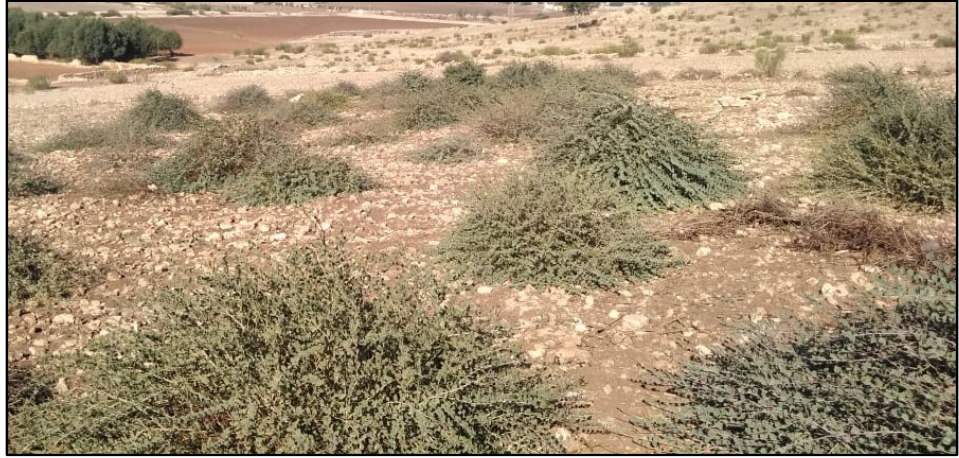
Figure 2. Wild caper ( Capparis spinosa L.) plants grown naturally in Morocco.